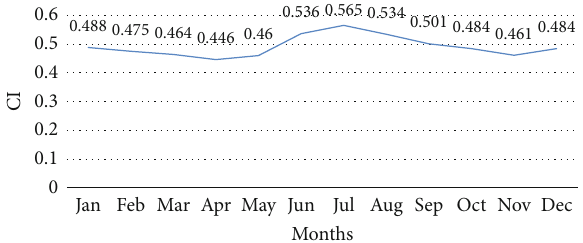
Figure 8: Monthly clearness index (CI) for Uganda.